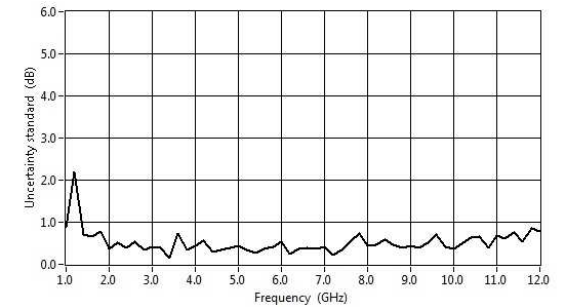
Figure 14: Standard uncertainty of corrected SE e in